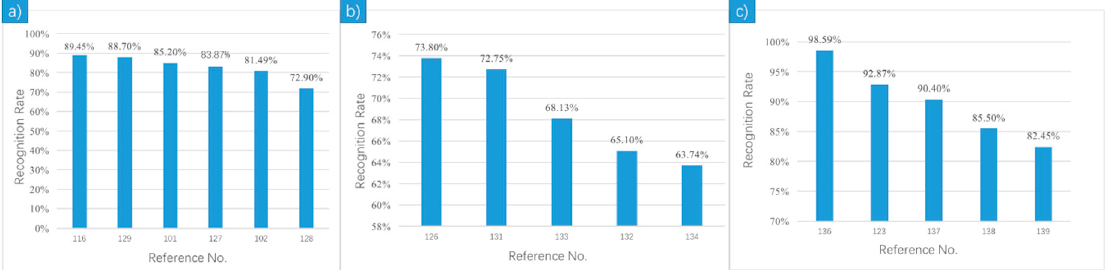
Figure 16. Comparative results on the same public accessible datasets: ( a ) DEAP; ( b ) MAHNOB; database; ( c ) SEED.